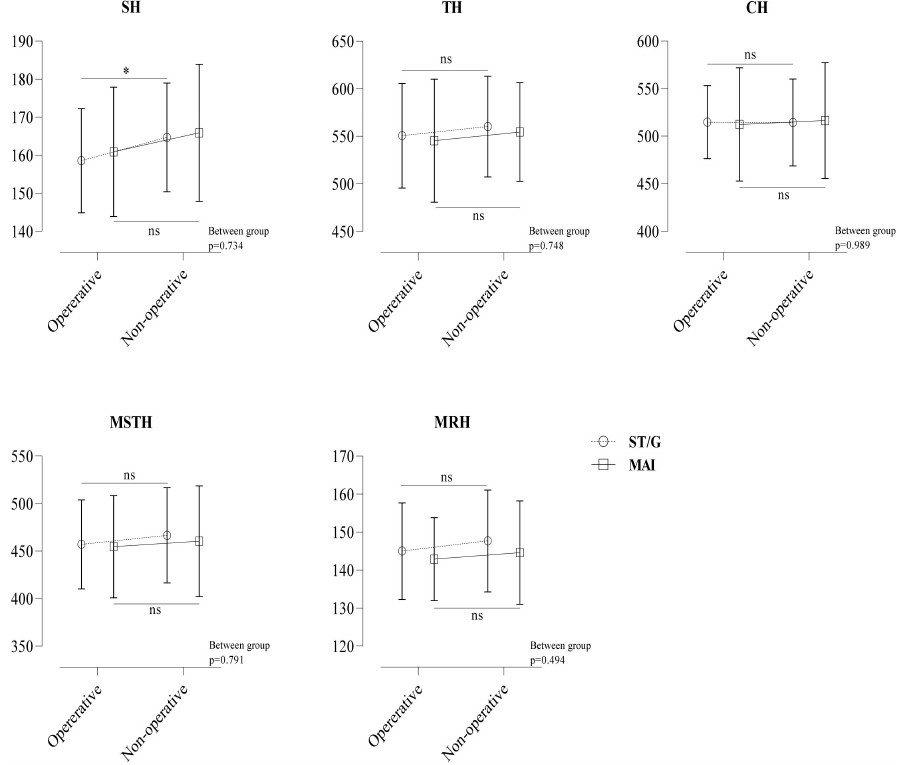
Figure 3. Differences in the hop test between operative and non-operative leg. * p < 0.05, ns = non-significant operative vs.